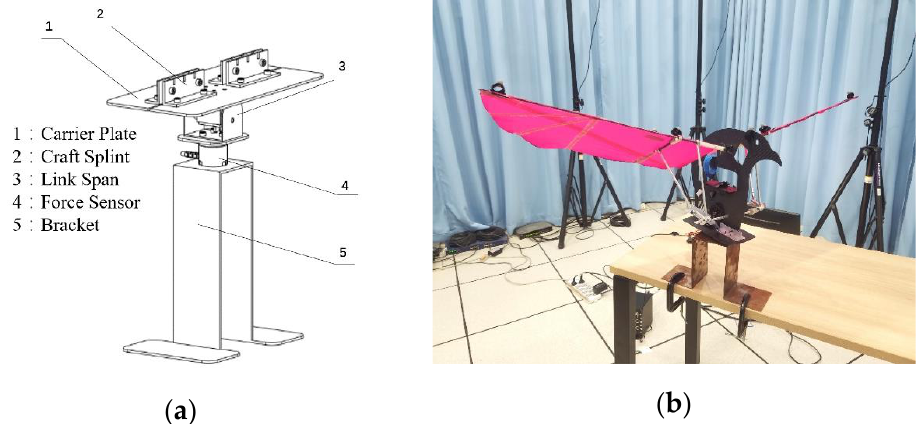
Figure 6. ( a ) Test rig for force measurement, and ( b ) the aircraft model mounted on the test rig. Table 3. The parameters of the cameras used in the experiment.